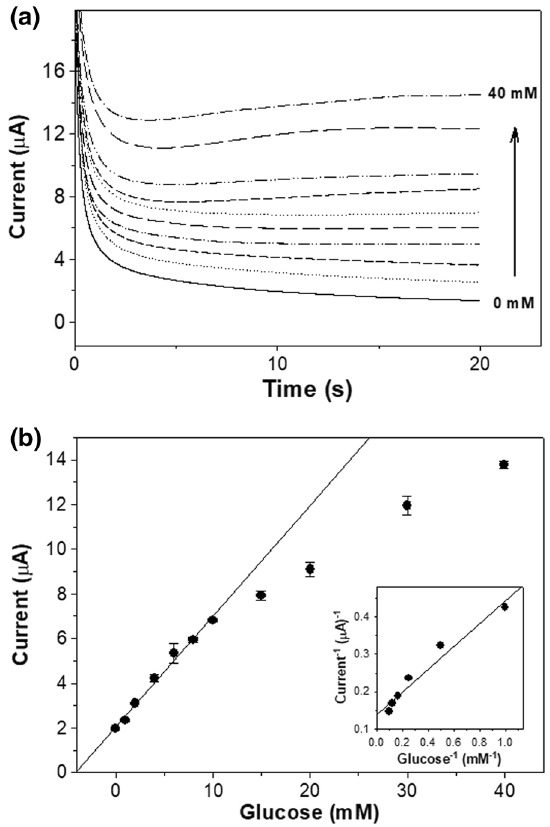
Fig. 5 a Chronoamperometry responses of glucose biosensor after the addition of a glucose solution with a concentration range of 0–40 mM. All responses were obtained at a constant cell potential of 0.3 V. b Calibration plot for a glucose biosensor. Inset: corresponding